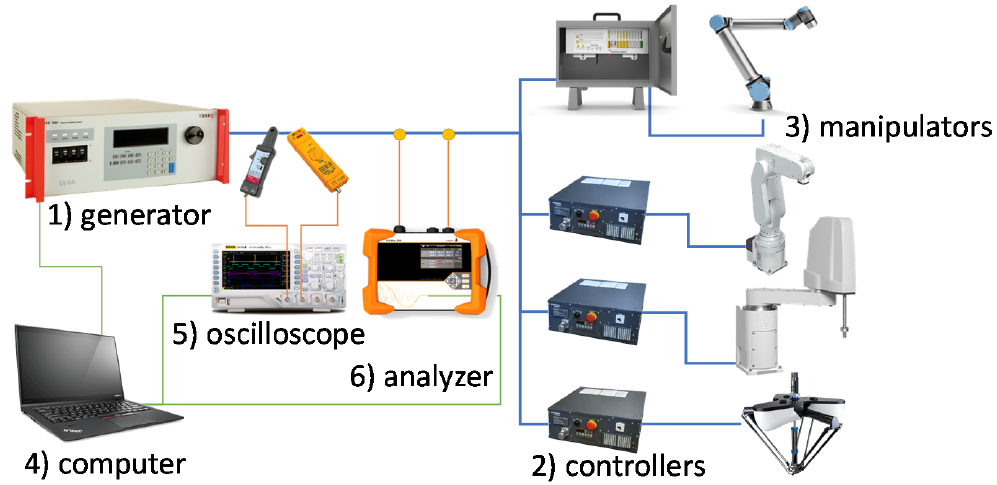
Figure 2. Diagram of the measuring system used to determine the allowable changes in IT equipment voltage as a function of time